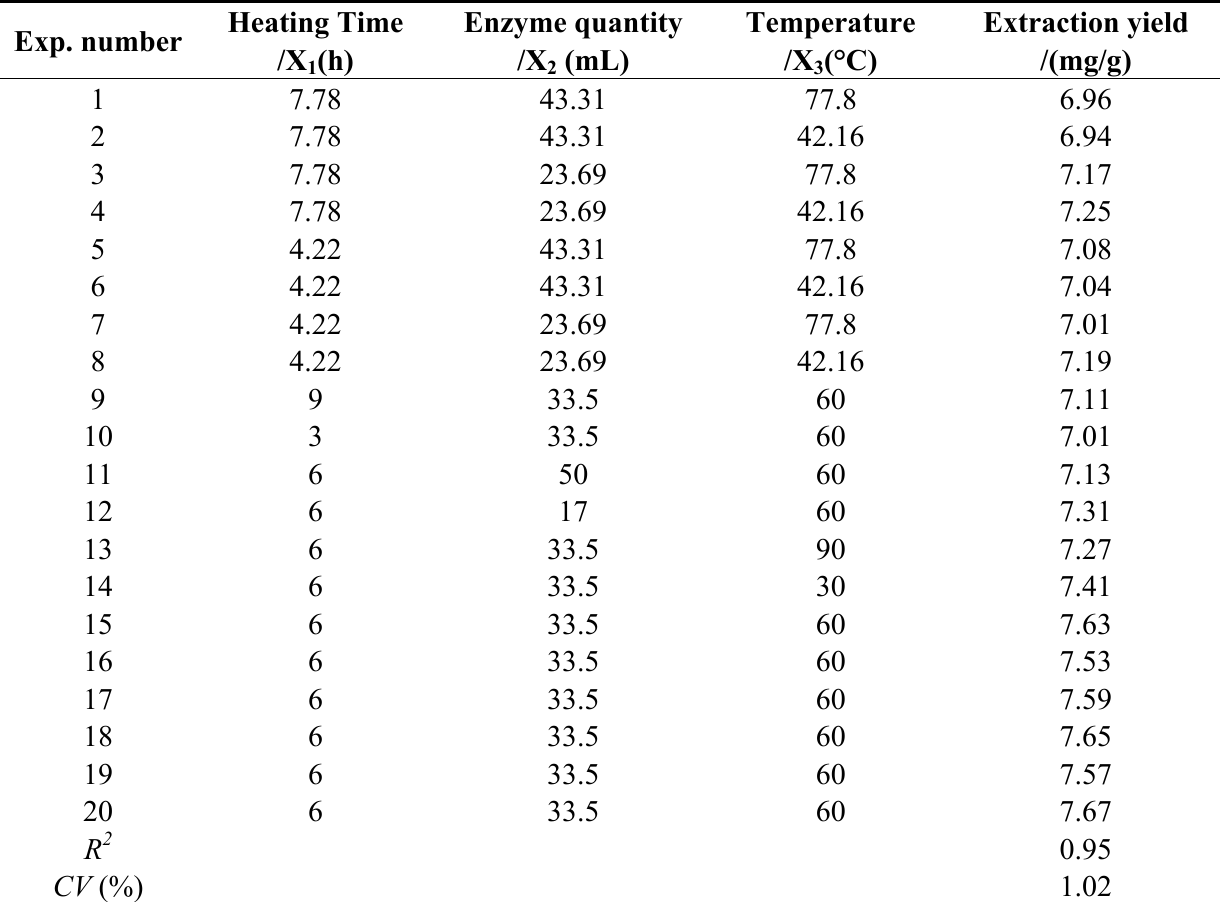
Table 1. Design program and experimental results of RSM.